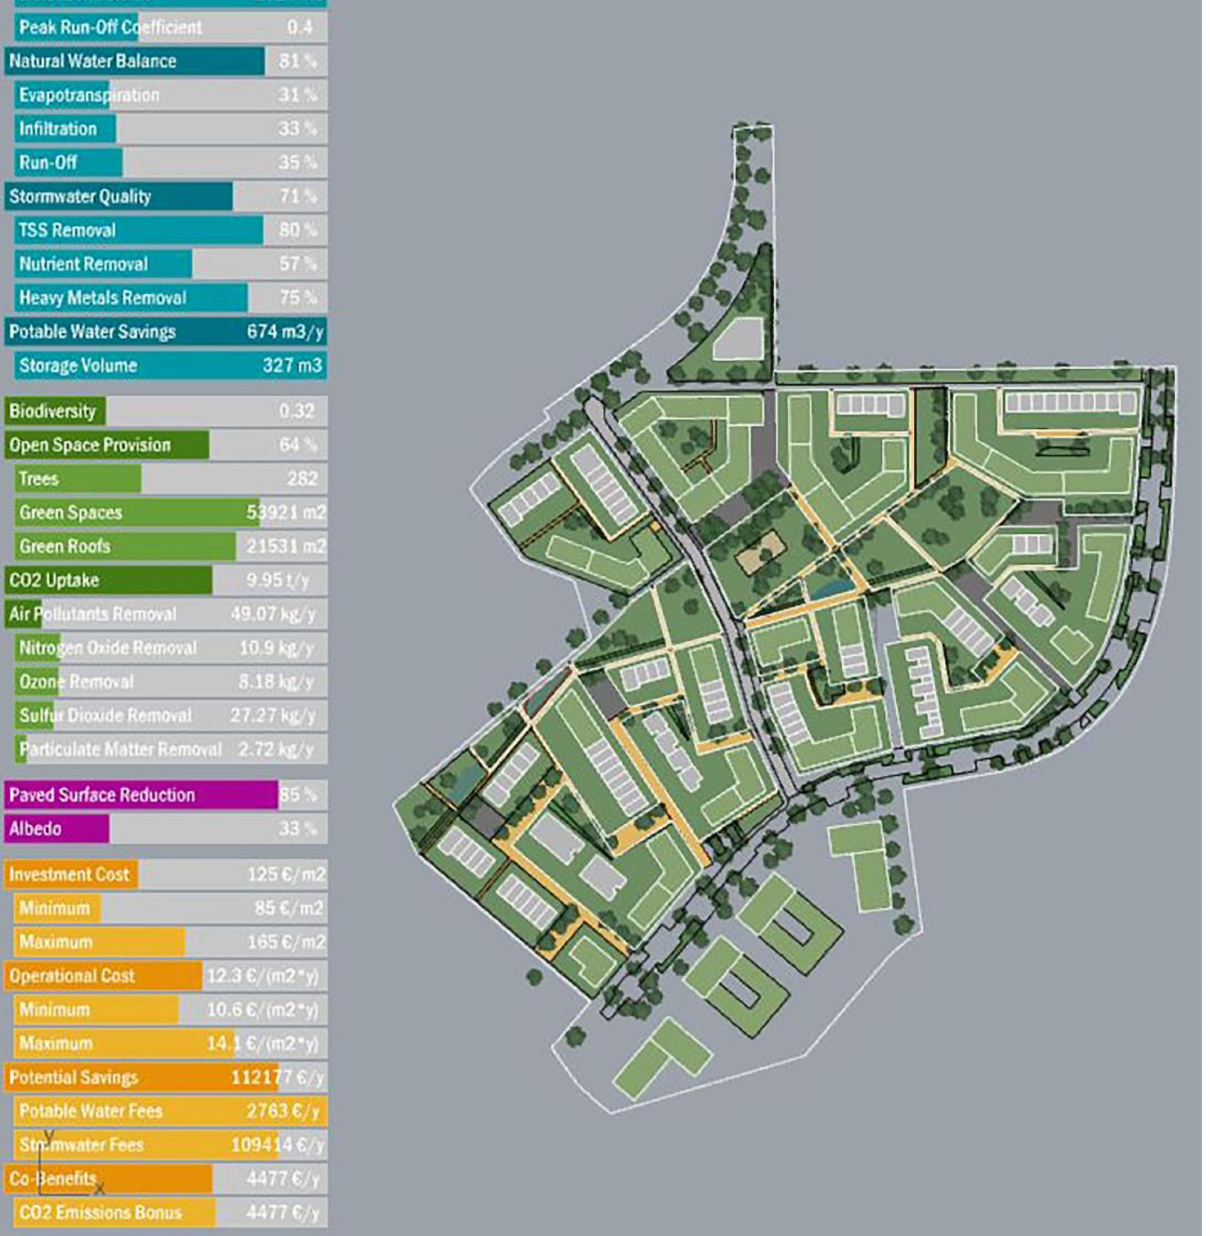
Figure 6. Final climate adaptation plan using GreenSceario (source: